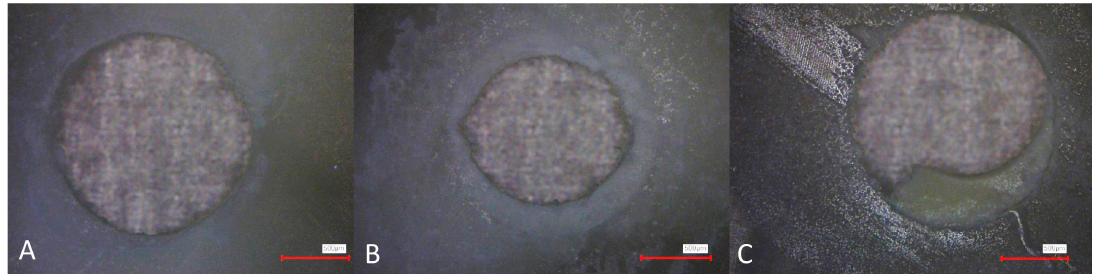
Figure 4. Images obtained by laser microscopy at 4× magnification for analysis of the mode of failure; examples for adhesive ( A ), cohesive ( B ), and mixed ( C ) failure types are given.